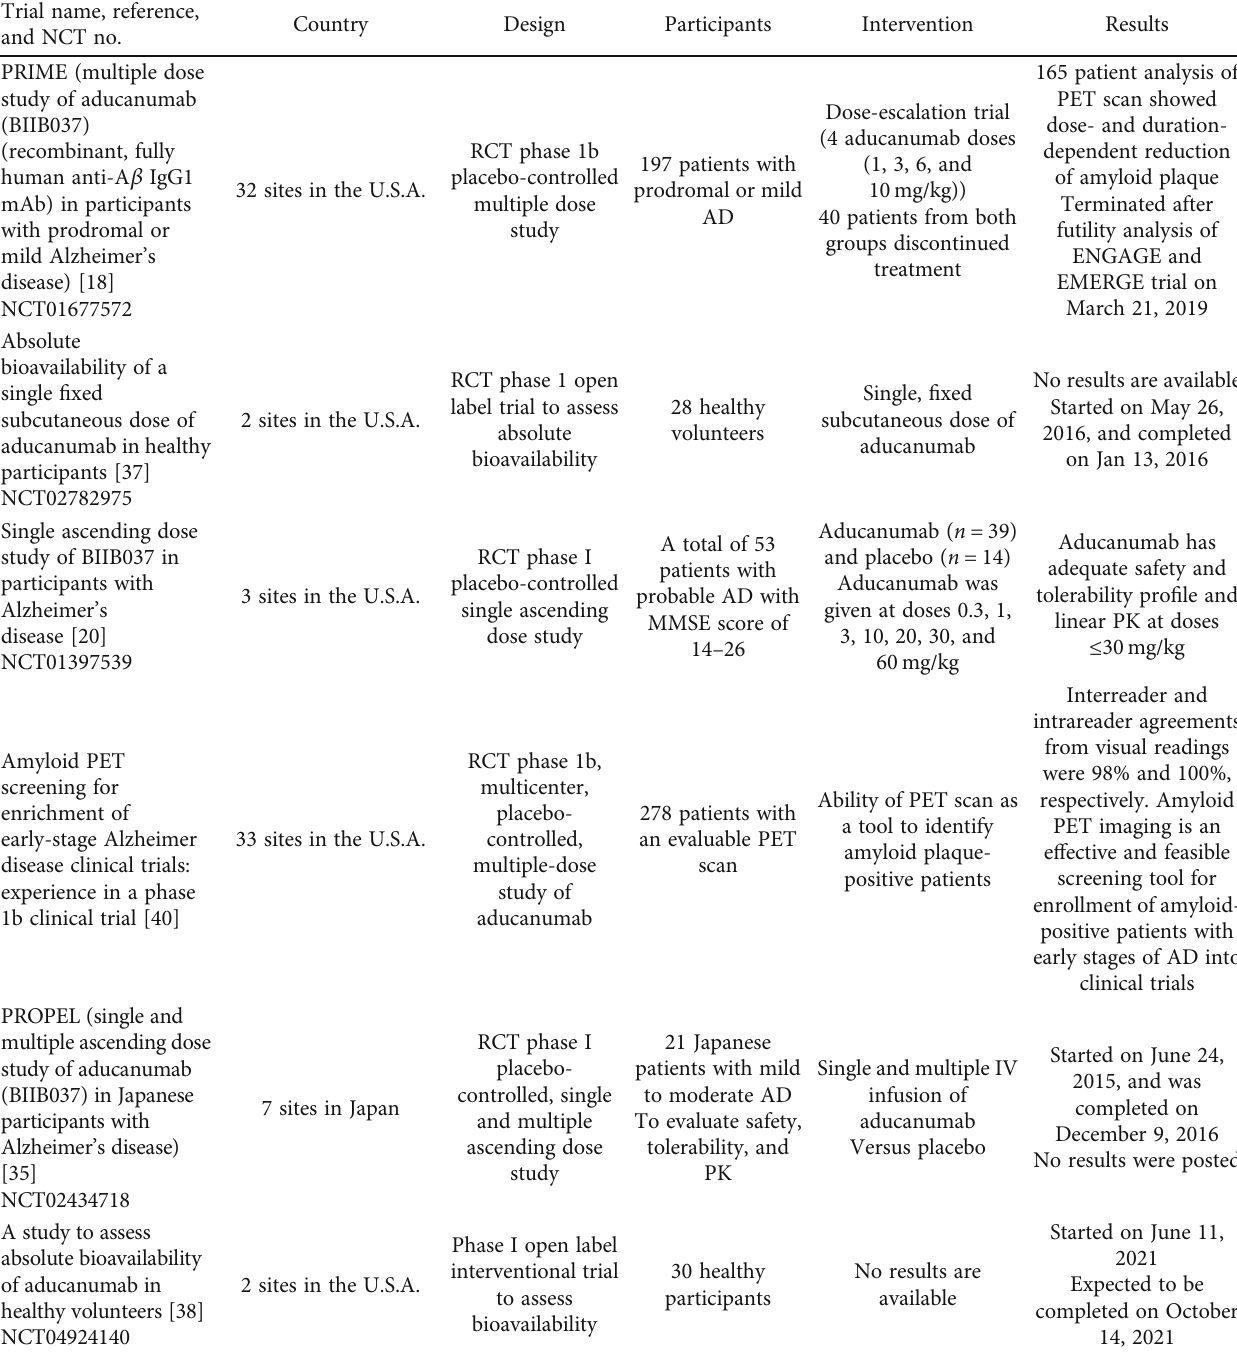
Table 1: Studies that evaluated the e ffi cacy or safety of